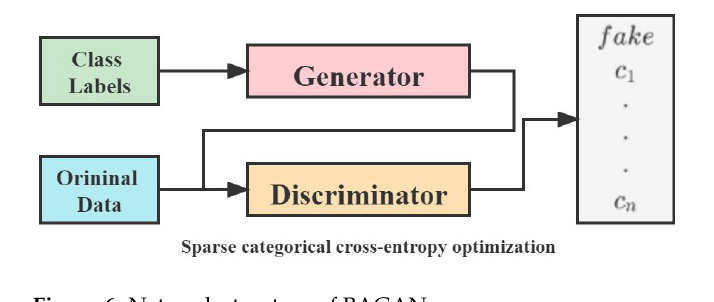
Figure 6. Network structure of